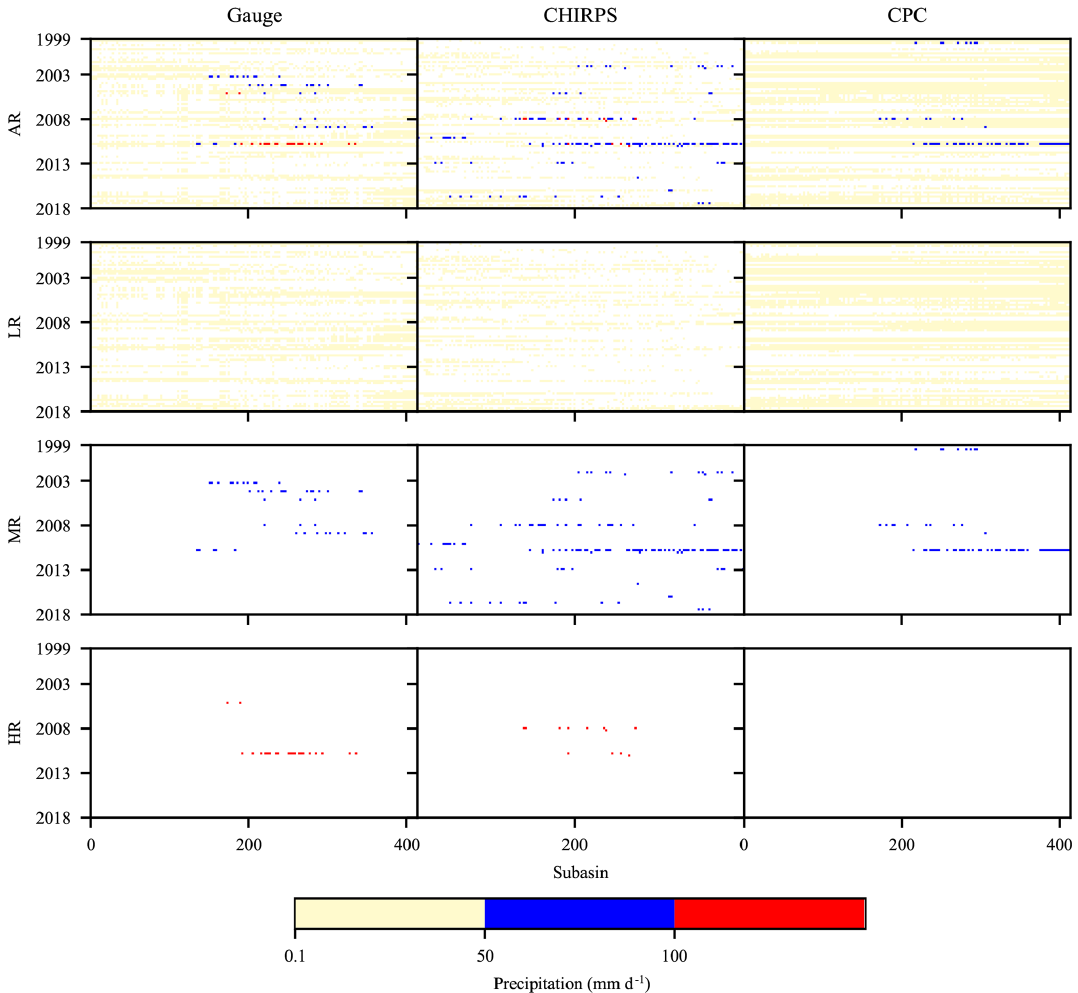
Figure 14. Full records of flood events that occurred throughout the study period and all subbasins detected by three precipitation products, where the AR, LR, MR, and HR stand for precipitation of all rainfall intensities, an intensity between 0.1 and 50mmd − 1 , an intensity between 50 and 100mmd − 1 , and an intensity more than 100mmd − 1 ,